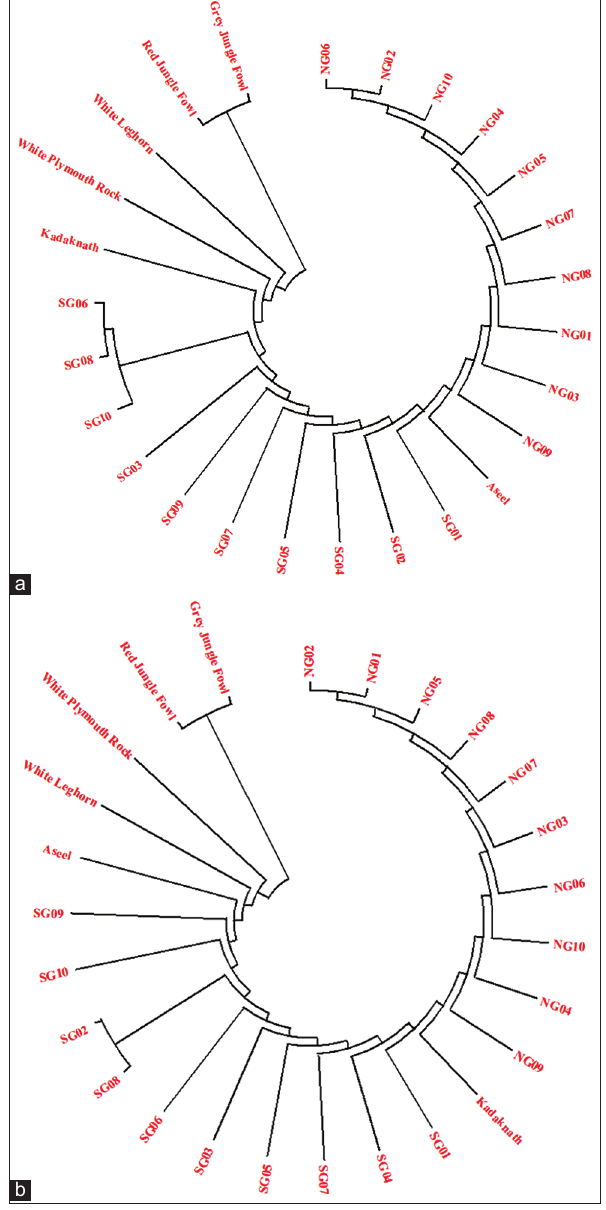
Figure-4: Phylogenetic trees made from obtained sequences of COX I gene (a), Cyt b gene (b) of Aravali and Ankleshwar chicken populations with sequences of domestic chicken breeds and two wild ancestors (Red Jungle Fowl and Gray Jungle Fowl). Aravali and Ankleshwar chicken show divergence from classical layer (White Leghorn) and meat (White Plymouth